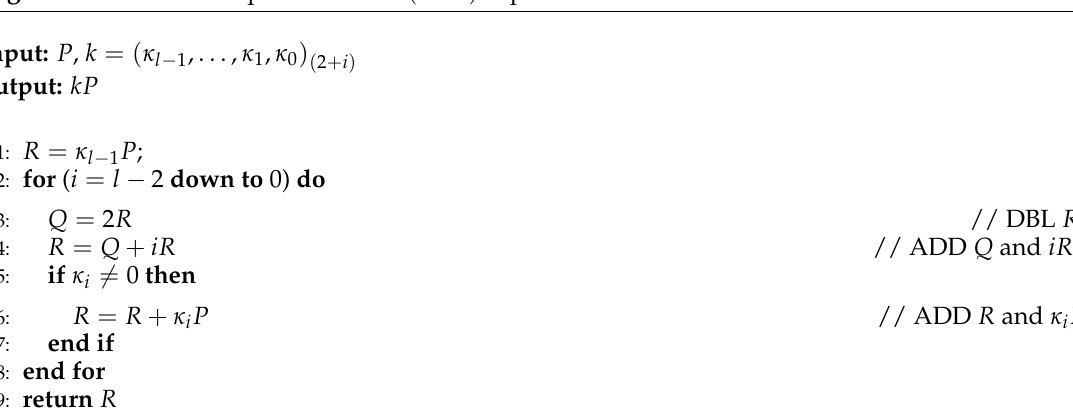
Algorithm 3 Point multiplication with ( 2 + i )